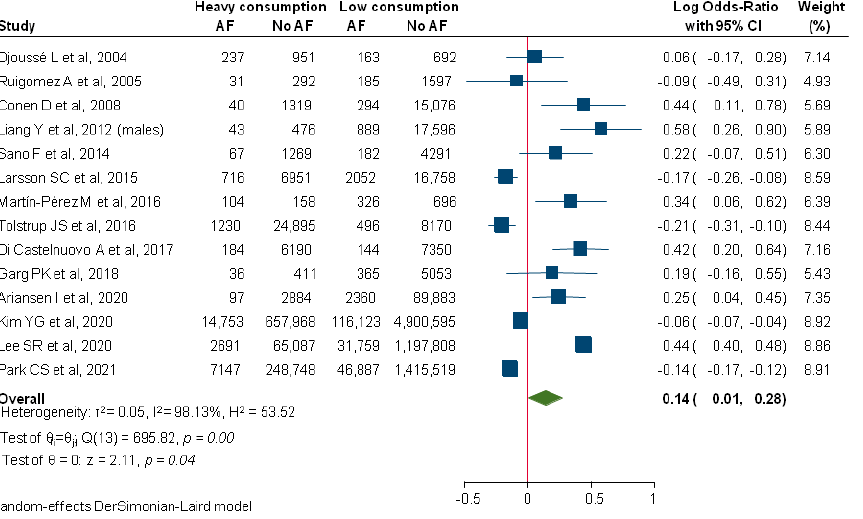
Figure 2. Comparison between heavy and low alcohol consumption regarding incident AF. AF, Atrial Fibrillation.